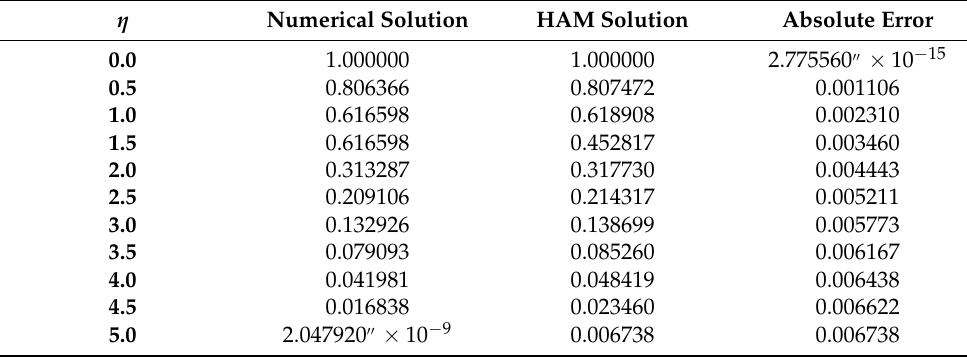
Table 2. Numerical solution via analytical solution for temperature profile.